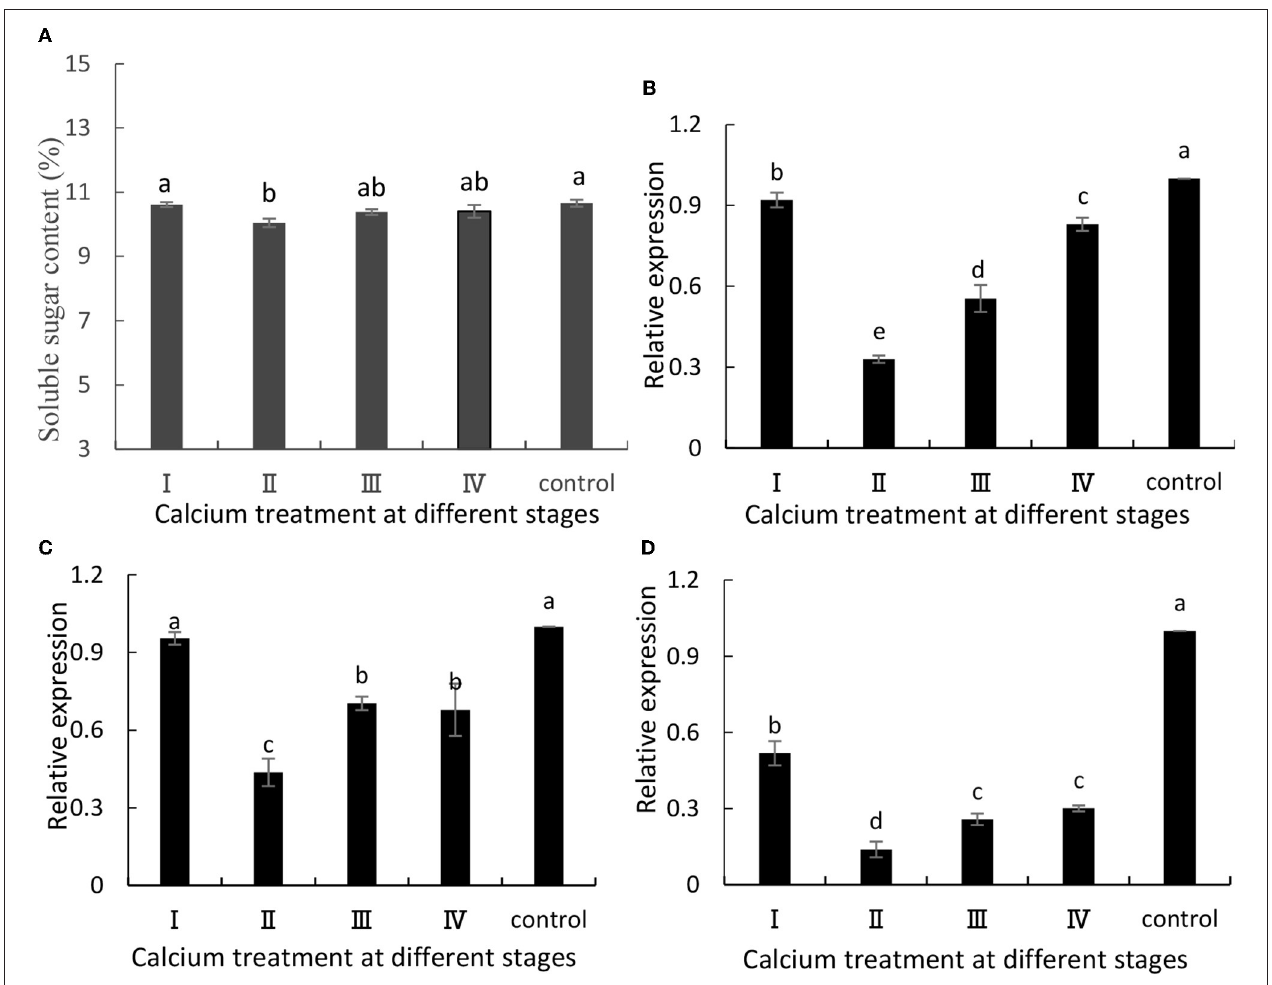
( Figure 3B ), VvHT3 ( Figure 3C ), and VvGIN1 ( Figure 3D )] are crucial genes involved in sugar synthesis, and their expression levels were decreased. Specifically, the II sample was decreased by 67, 54, and 86%, respectively, compared with the control group ( Figure 3